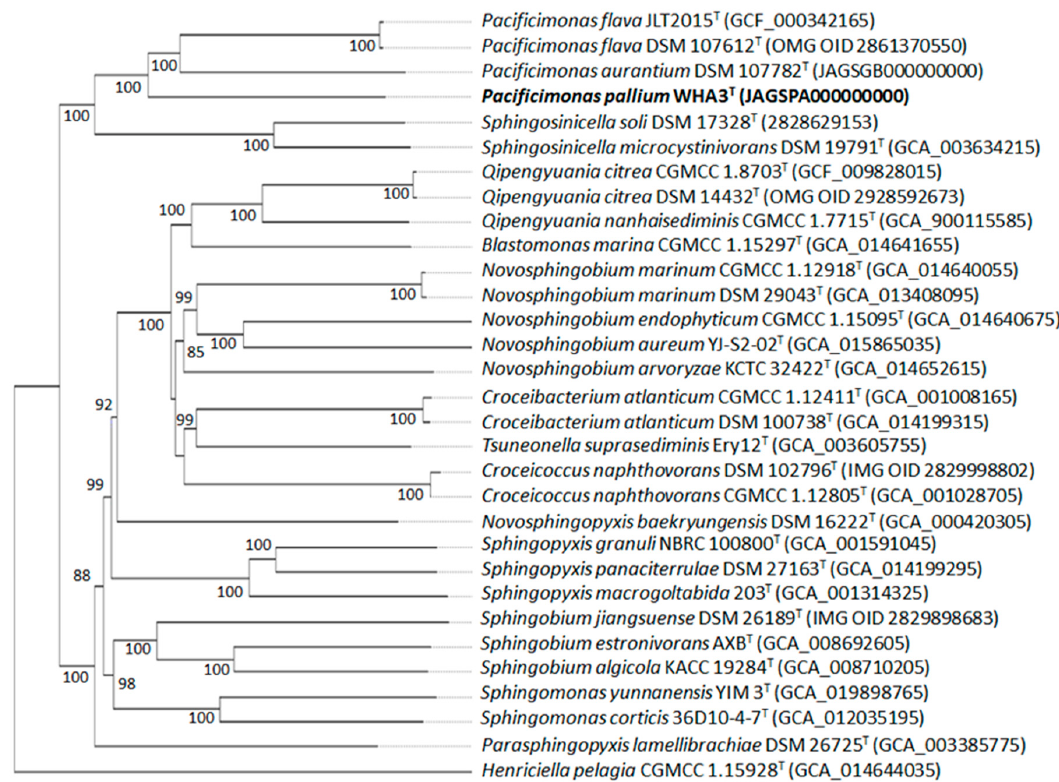
Figure 3. Phylogenomic tree inferred from the whole-proteome-based GBDP distances between strain WHA3 T and the closely related type strains based on Type (Strain) Genome Server (TYGS) (https://tygs.dsmz.de/ accessed on 11 November 2021). The numbers at the nodes are GBDP pseudo- bootstrap support values >60% from 100 replications, with an average branch support of 94.9%.